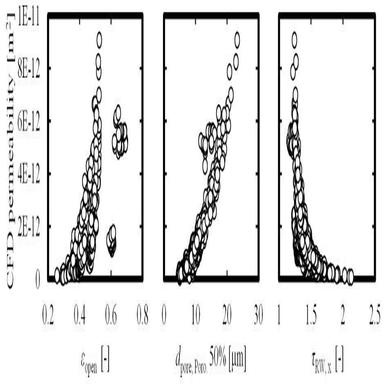
Dependency of permeability on the open porosity (εopen), median of pore diameter measured by virtual porosimetry (dpore, Poro 50%), and random walk tortuosity in the x direction (τRW, x).